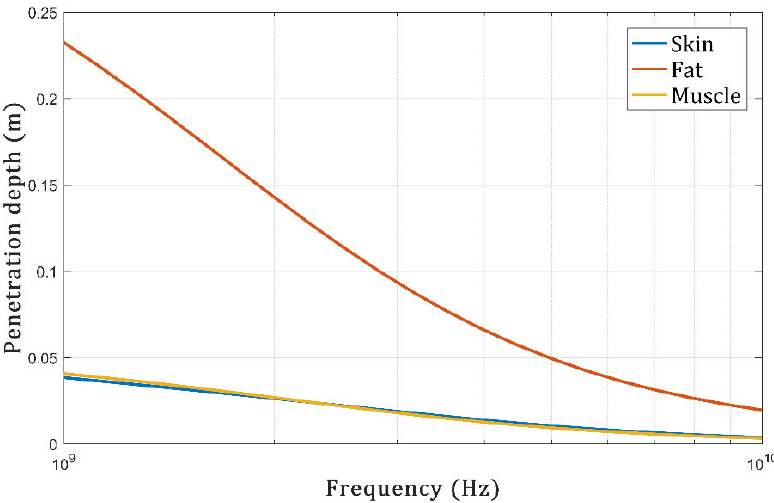
Figure 1. The relation between frequency (1000 MHz–10 GHz) and the penetration depth for different tissues